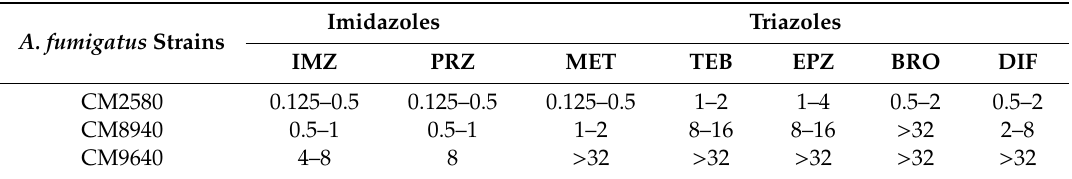
Table 2. Minimal inhibitory concentrations (MICs) in mg / L for A. fumigatus isolates against 14- α sterol demethylation inhibitors (DMIs) (IMZ: imazalil, PRZ: prochloraz, MET: metconazole, TEB: tebuconazole, EPZ: epoxiconazole, BRO: bromuconazole, DIF: difenoconazole).